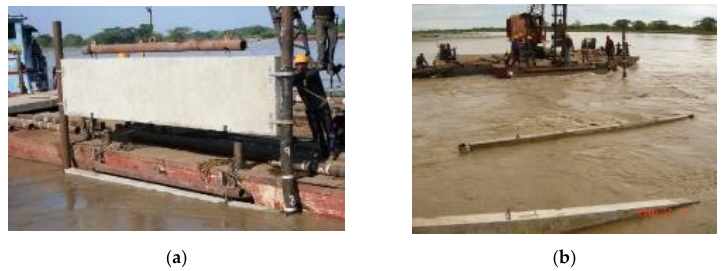
Figure 21. Cauca River, Guarumo: ( a ) positioning and installation of a double unit; ( b ) a set of vanes in the process of installation (Hidroconsulta, 2008).